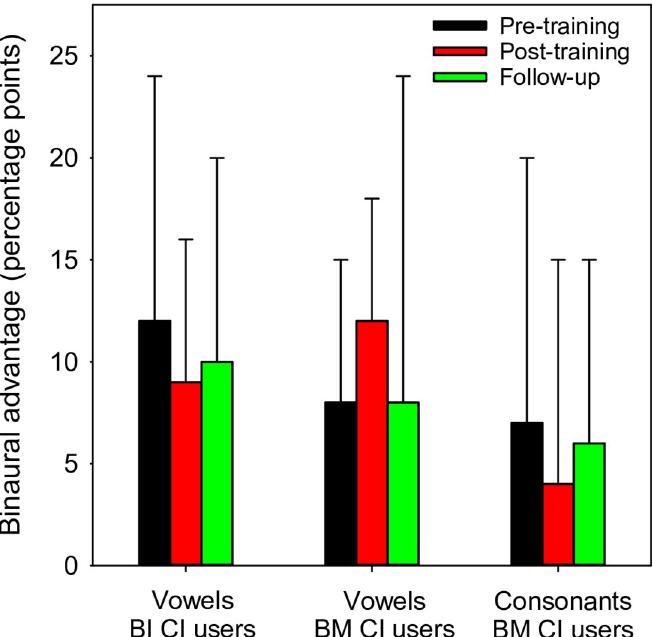
Fig 6. Mean binaural advantage at pre-training, post-training, and follow-up. Binaural advantage was calculated as the difference between binaural and CI-only performance. Data are shown for vowel recognition in bilateral CI users, and for vowel and consonant recognition in bimodal CI users. The error bars show the standard